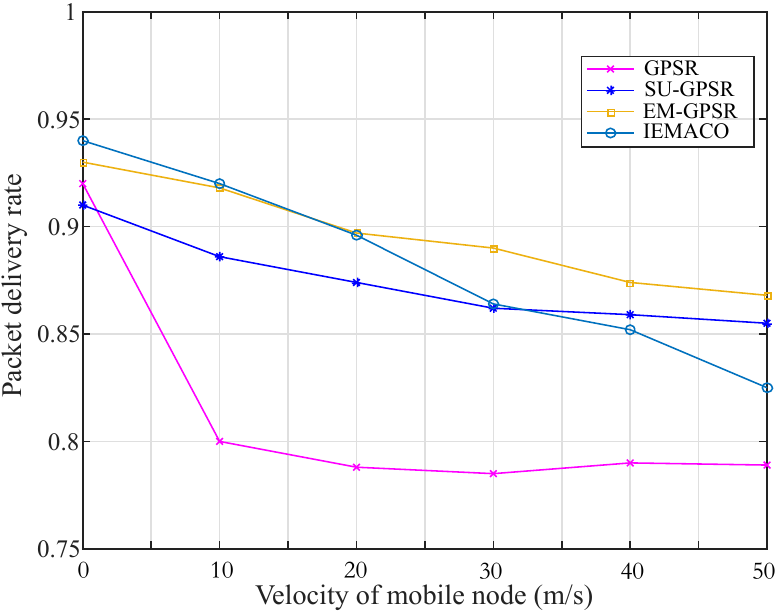
Figure 9. Packet delivery rates versus the velocity of a mobile